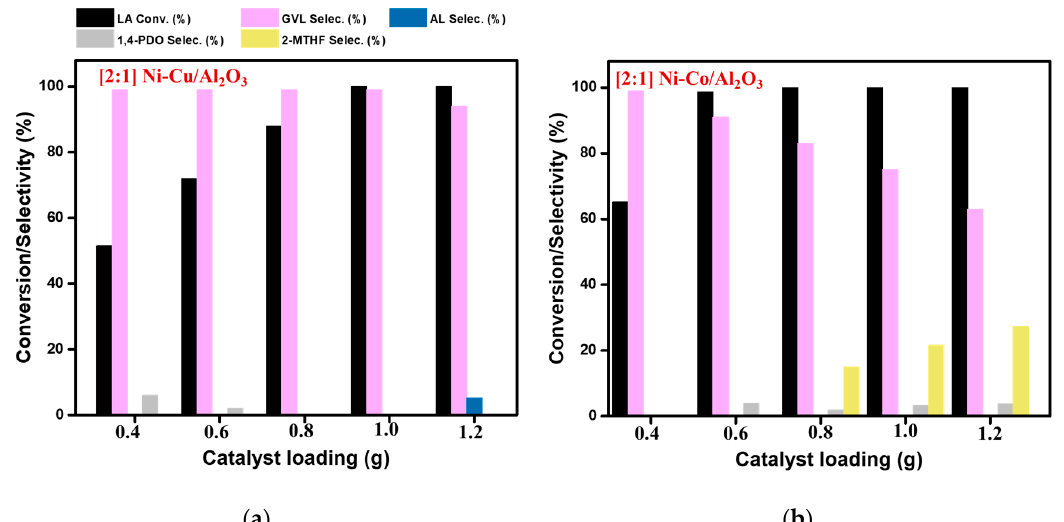
Figure 12. Reaction results for the effect of catalyst loading over ( a ) [2:1] Ni-Cu/Al 2 O 3 and ( b ) [2:1] Ni-Co/Al 2 O 3 on the hydrogenation of LA. Reaction conditions: 20 mL LA, 220 °C, 30 bar H 2 pressure and 6 h reaction time.